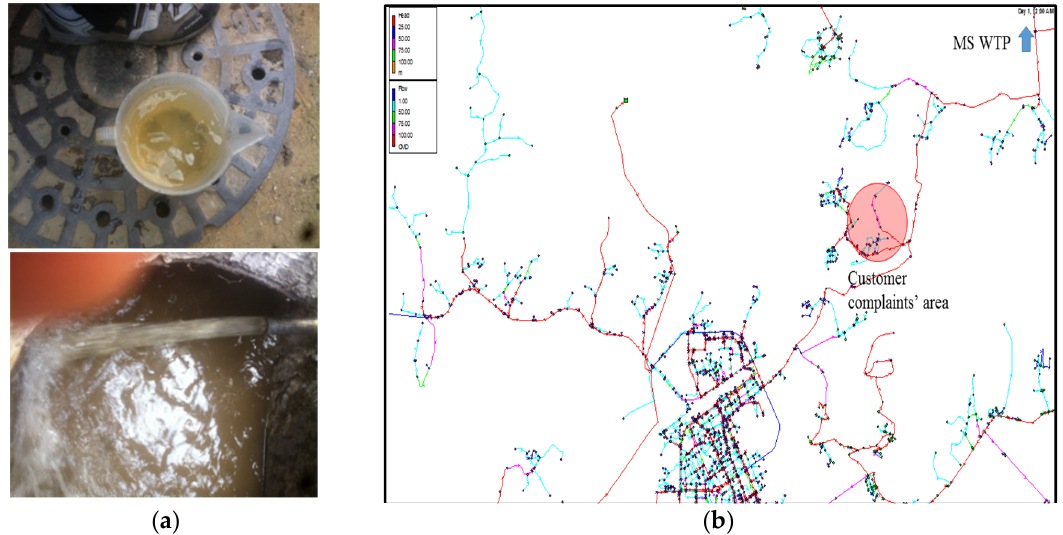
Figure 7. Discolored water and hydraulic simulation results for the PJ water distribution system. ( a ) Discolored water; ( b ) Hydraulic simulation results.